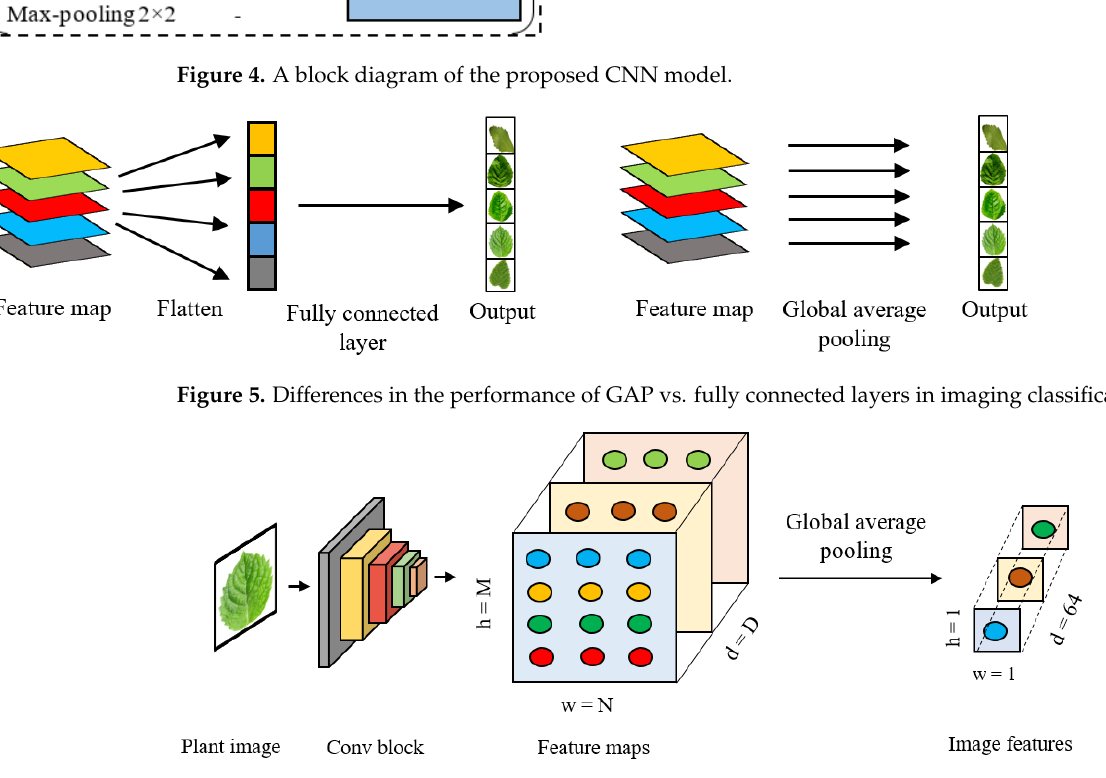
Figure 4. A block diagram of the proposed CNN model.